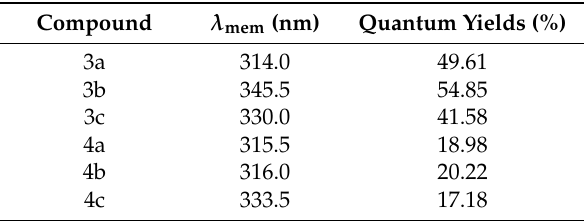
Figure 3. The absorption and emission spectra of benzofuran derivatives 3a – c and 4a – c in cyclohexane. Excitation wavelengths were: 300 nm for 3a , 312 nm for 3b , 297 nm for 3c , 304 nm for 4a , 290 nm for 4b , and 276 nm for 4c . Table 3. Fluorescence parameters: emission maximum wavelength, λ mem and fluorescence quantum yield, of compounds 3a – c and 4a – c in